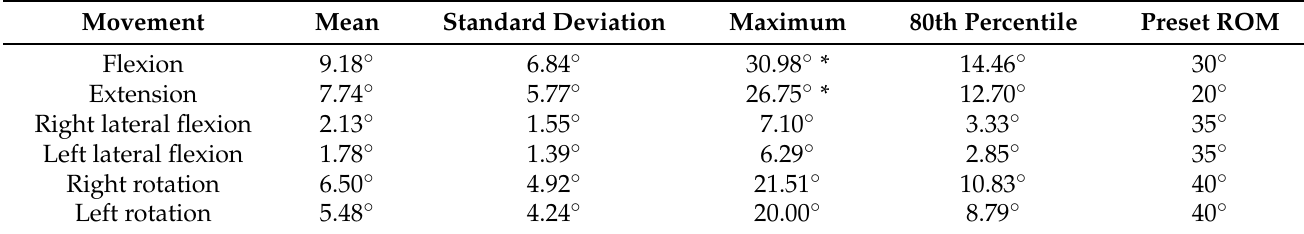
Table 4. ROM results of Profile 2 (After outlier filtering, the analyzed data for the Profile 2 supposed a 98% of the total flexion-extension raw data, a 97% of the total lateral flexion raw data, and a 98% of the total rotation raw data). The cases where the maximum ROM of the subjects reported by the ENLAZA inertial sensors exceeded the preset ROM defined for the profile are marked with an asterisk.